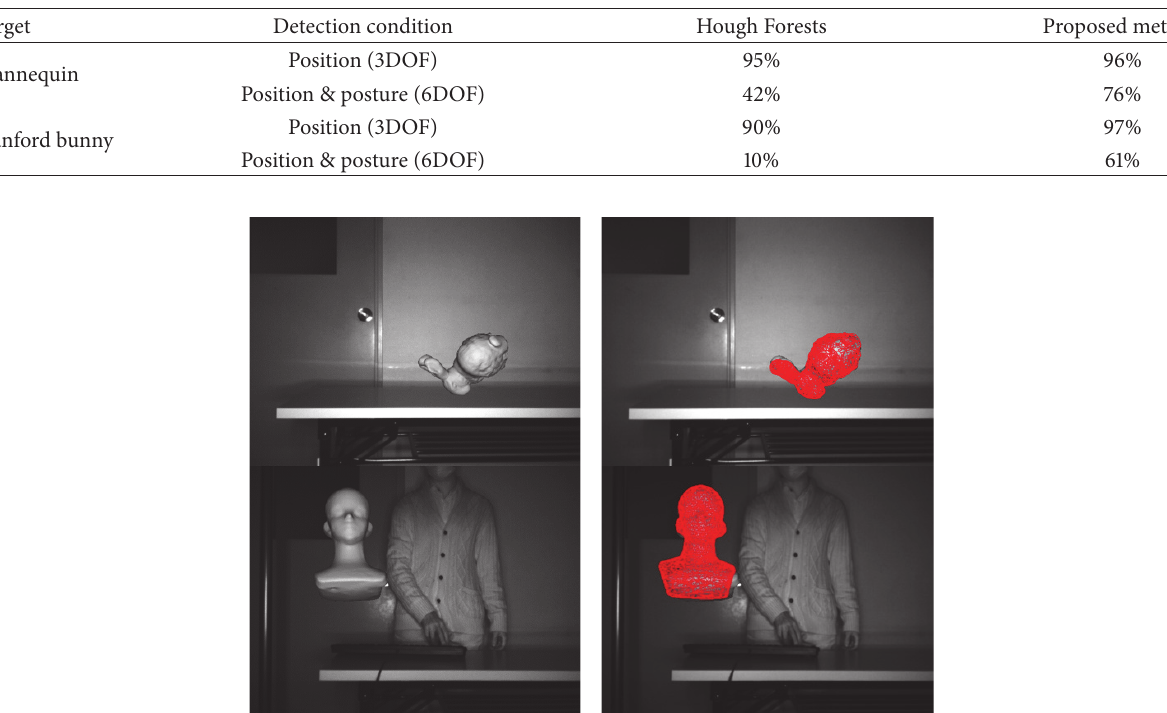
Figure 8: Result of position and posture estimation optimized with